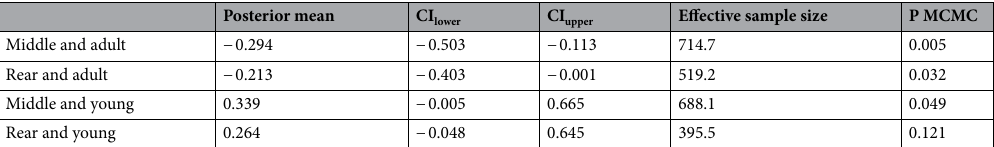
Table 4. Effect of age (adult, young) on the likelihood for an individual to take a front, middle, or rear position during a group progression. Reference categories are the front third of adult and young. Posterior means, confidence intervals, sample size, and P-values derived from MCMC procedure.